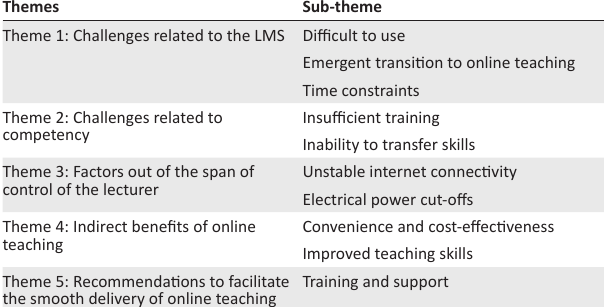
TABLE 2: Themes and sub-themes of lecturers’ experiences with online